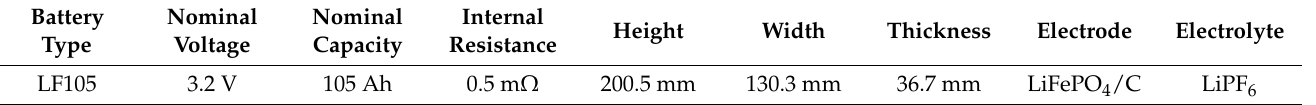
Table 1. The dimensions and basic parameters of LF105 battery.